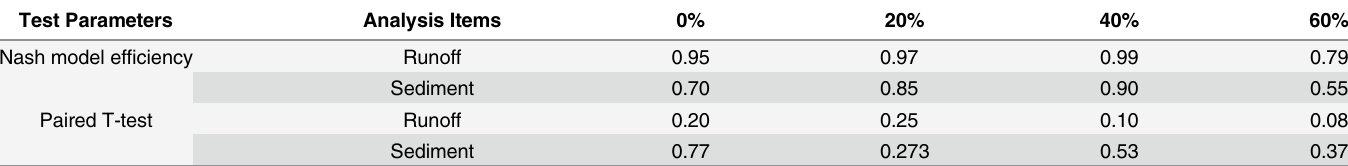
Table 2. WEPP model performance using erosion plot data.